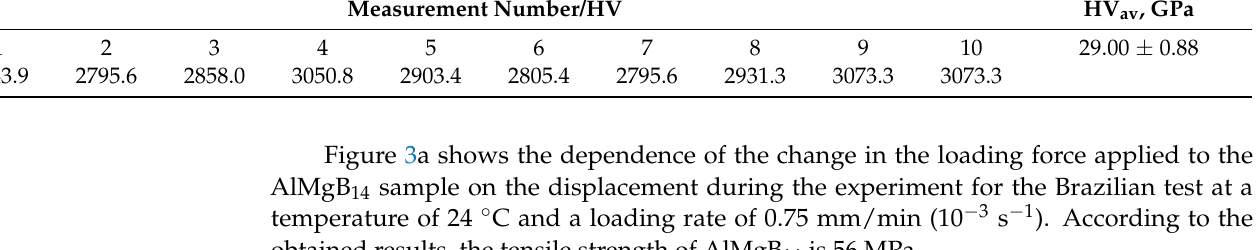
Table 3. The results of measuring the hardness of the obtained sample. Measurement Number/HV